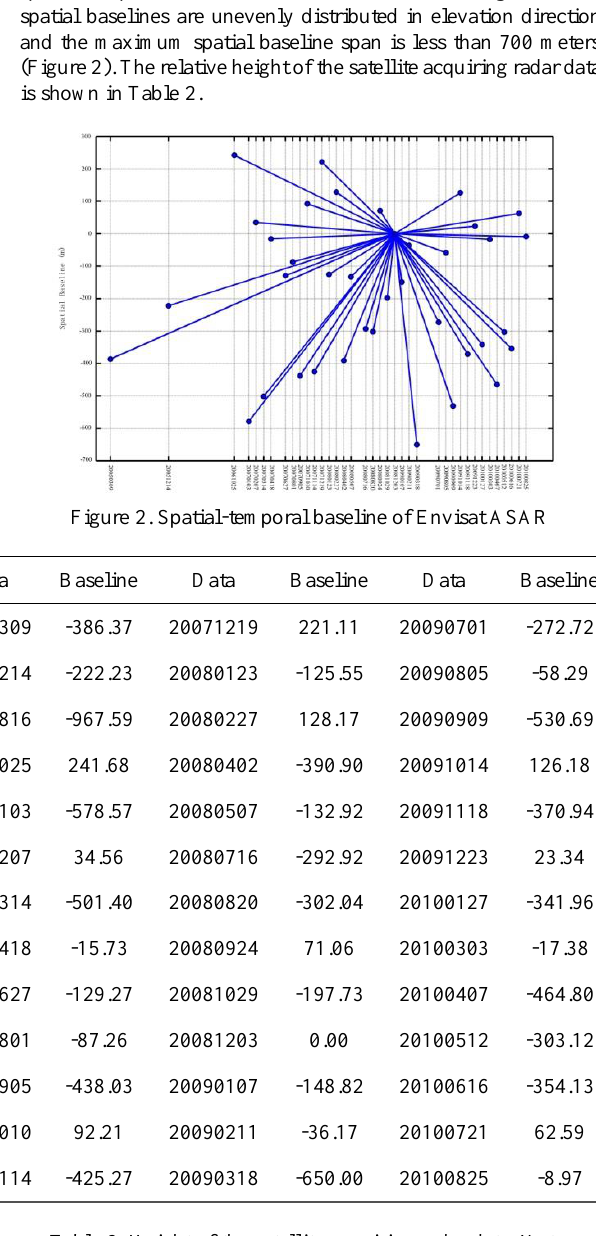
Table 2. Height of the satellite acquiring radar data. Note: Baseline represents the distance between master image and